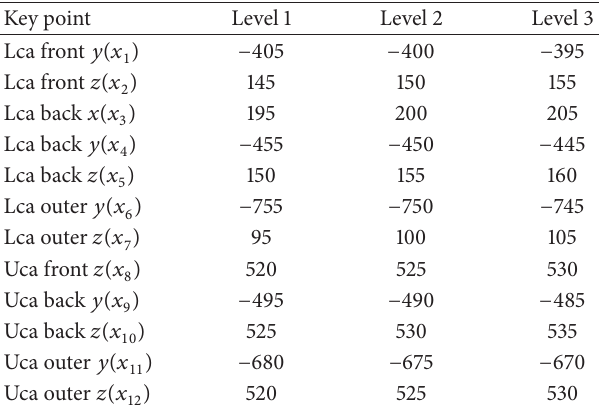
Table 2: Impact of each variable. Table 3: Controllable